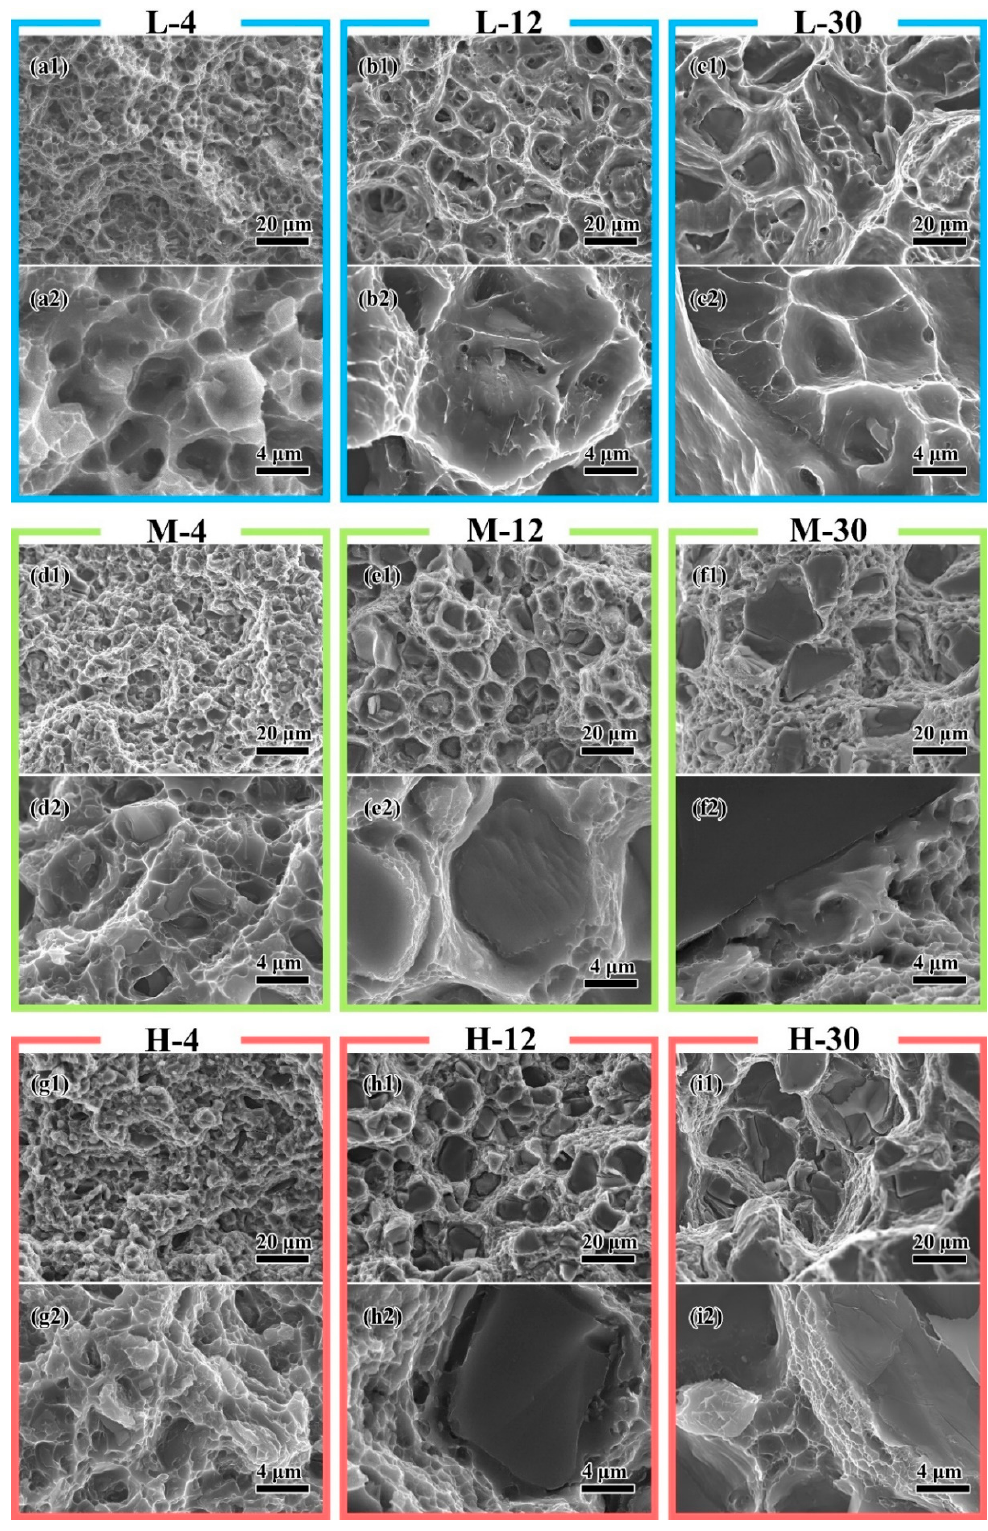
Figure 4. The typical fracture morphologies of ( a ) L-4, ( b ) L-12, ( c ) L-30, ( d ) M-4, ( e ) M-12, ( f ) M-30, ( g ) H-4, ( h ) H-12, and ( i ) H-30. The two images in each group are the images with different magnifications of ( 1 ) 1000 × and ( 2 ) 5000 × .